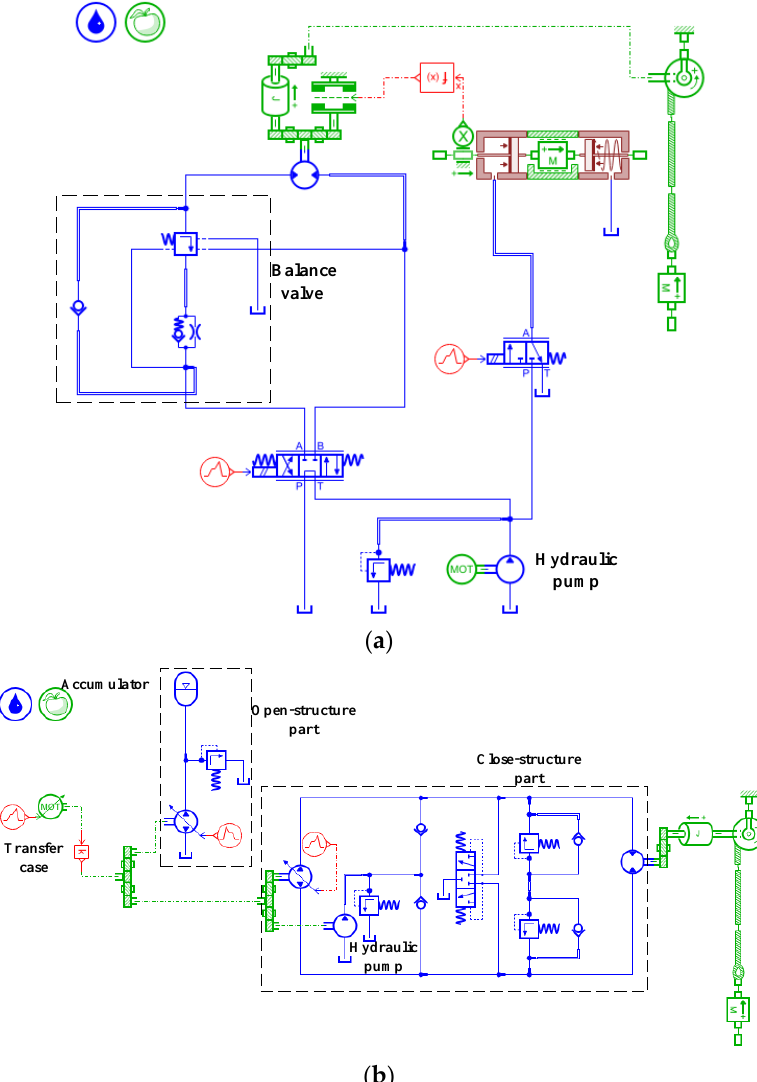
Figure 3. AMESim models of the original open system and proposed system for winch. ( a ) Original open system; ( b ) Proposed system with energy-saving. Table 1. Parameters match of the two systems.